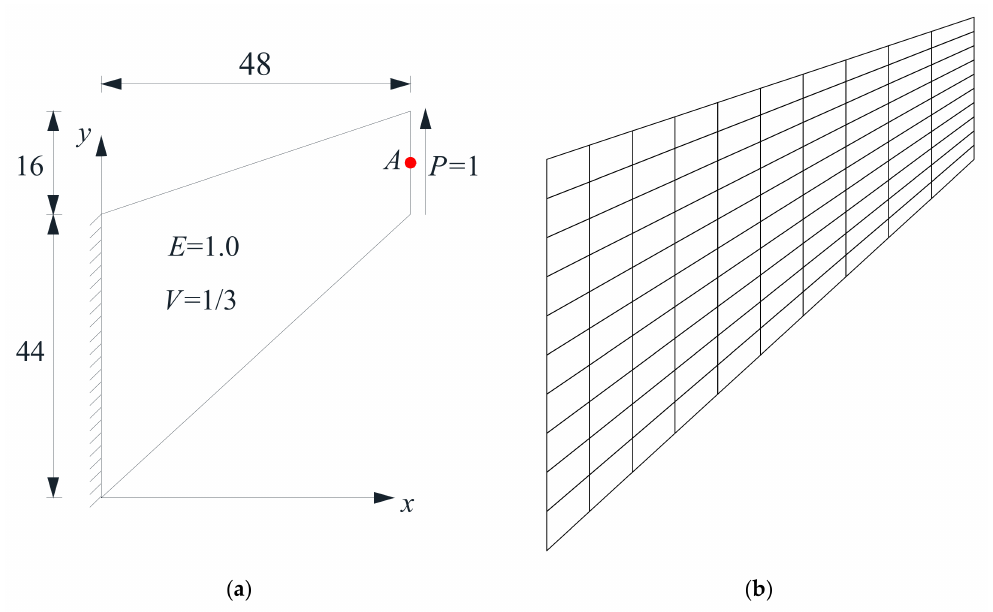
Figure 6. Cook’s skew beam: ( a ) geometry and load; ( b ) a mesh with 10 × 10